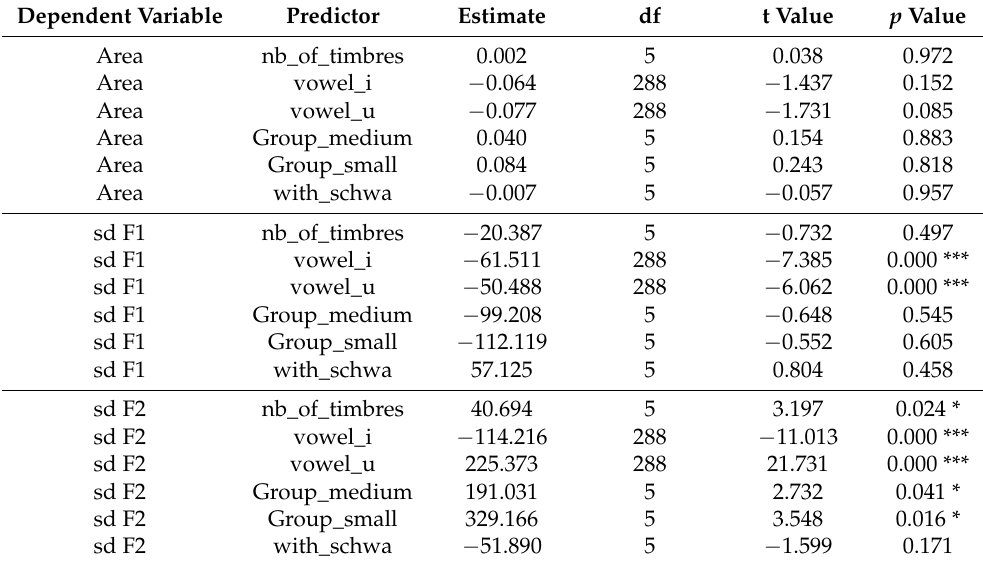
Table 3. The output of linear mixed models based on the output of 10 vowel samplings with 50 tokens for each vowel in each language. The abbreviations are read as follows: nb_of_timbres = number of timbres, sd = standard deviation. The significance codes are interpreted as follows: * indicates a p value < 0.05, *** indicates a p value <